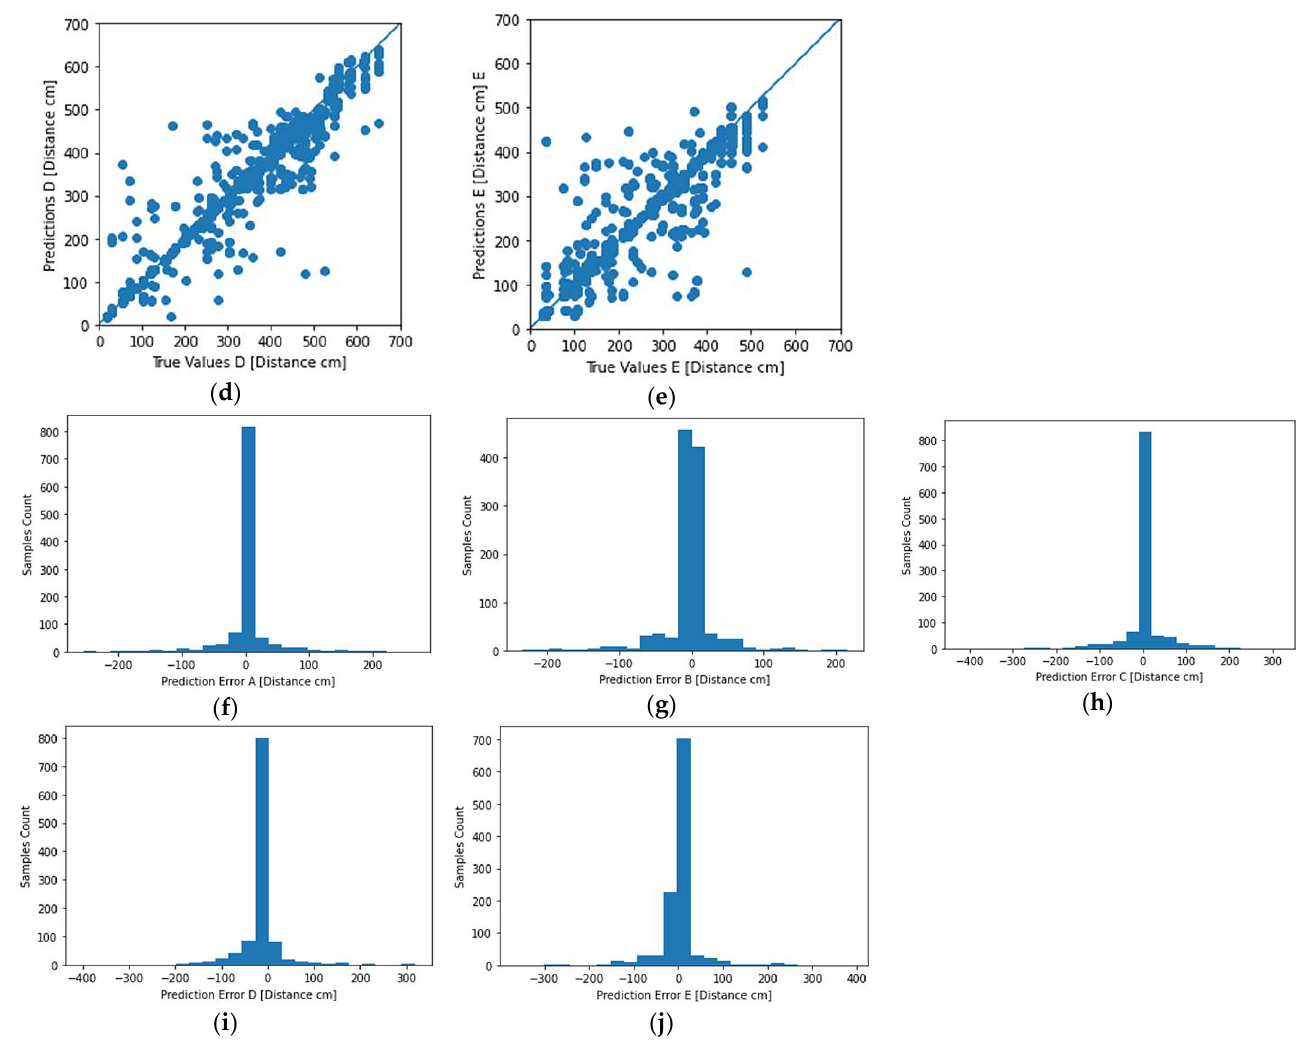
Figure 6. Inference scattering diagrams for nodes A ( a ), B ( b ), C ( c ), D ( d ), and E ( e ) (predicted distance in cm (y-axis) vs. true value ( x -axis) in cm). Inference error distributions for nodes A ( f ), B ( g ), C ( h ), D ( i ), and E ( j ) (sample count ( y -axis) vs. prediction error ( x -axis) in cm).